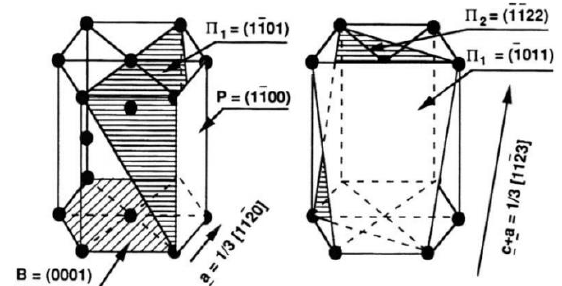
Figure 1. Slip systems in α -Ti: basal (B), prismatic (P) and first-order pyramidal ( Π 1) planes containing Burgers vector a ; first and second-order ( Π 2) pyramidal slip planes containing Burgers vector c + a [55].